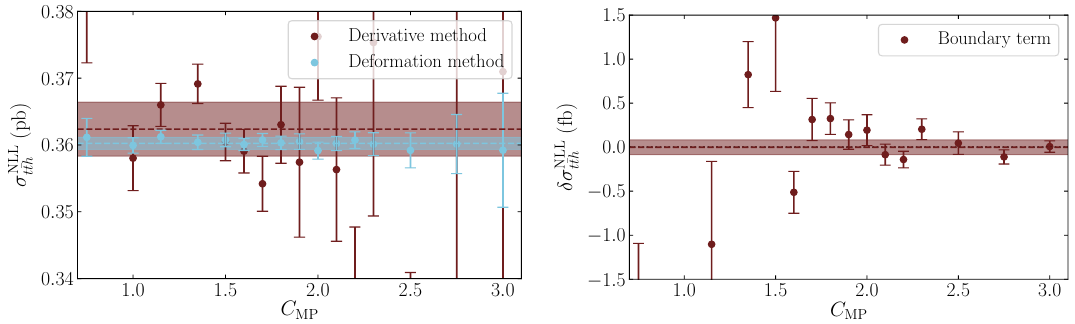
and µ = µ for different values of C and low MP t ¯ t